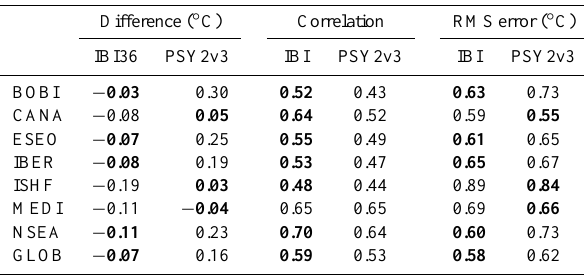
Figure 11 : 2009 annual mean salinity profile off Spanish coast : black line for WOA 2005 climatology (http://www.nodc.noaa.gov/OC5/WOA05/pr_w oa05.html), blue line for V1 system (IBI36- CONT) and red line for V2 system.